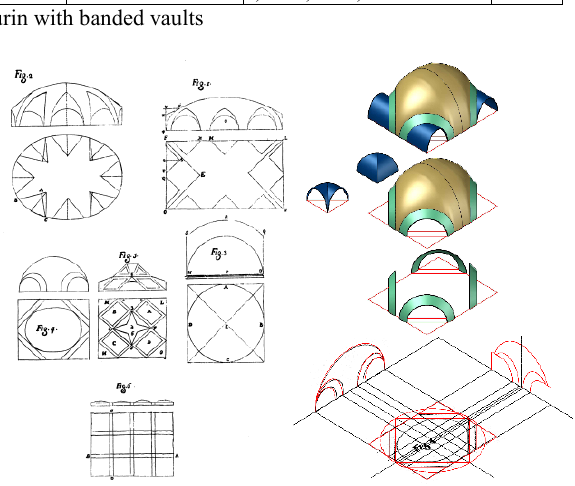
Figure 2. Banded vault in the Architettura civile by Guarini. Source: Guarini, 1737. Modeling: R.